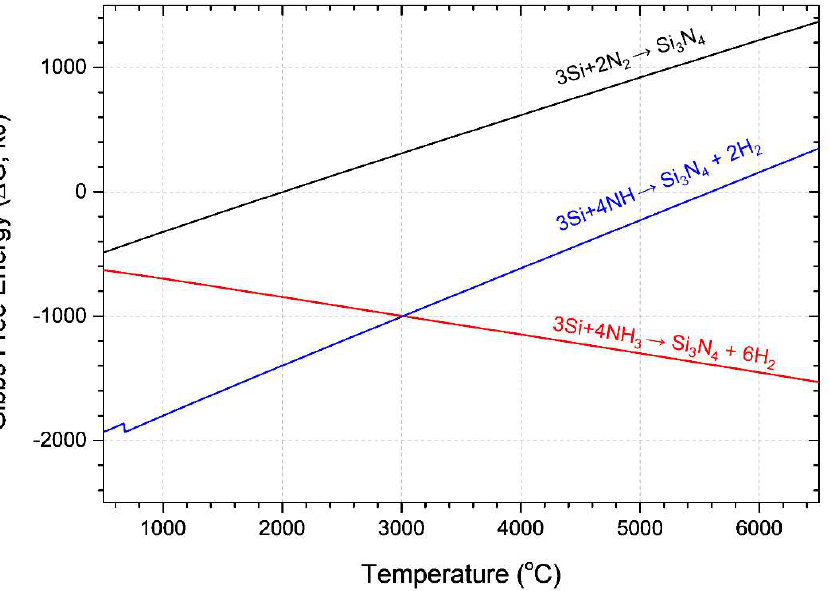
Figure 9. Change in Gibbs free energy (Δ G ) of the nitridation of Si by nitrogen and ammonia spe- cies.